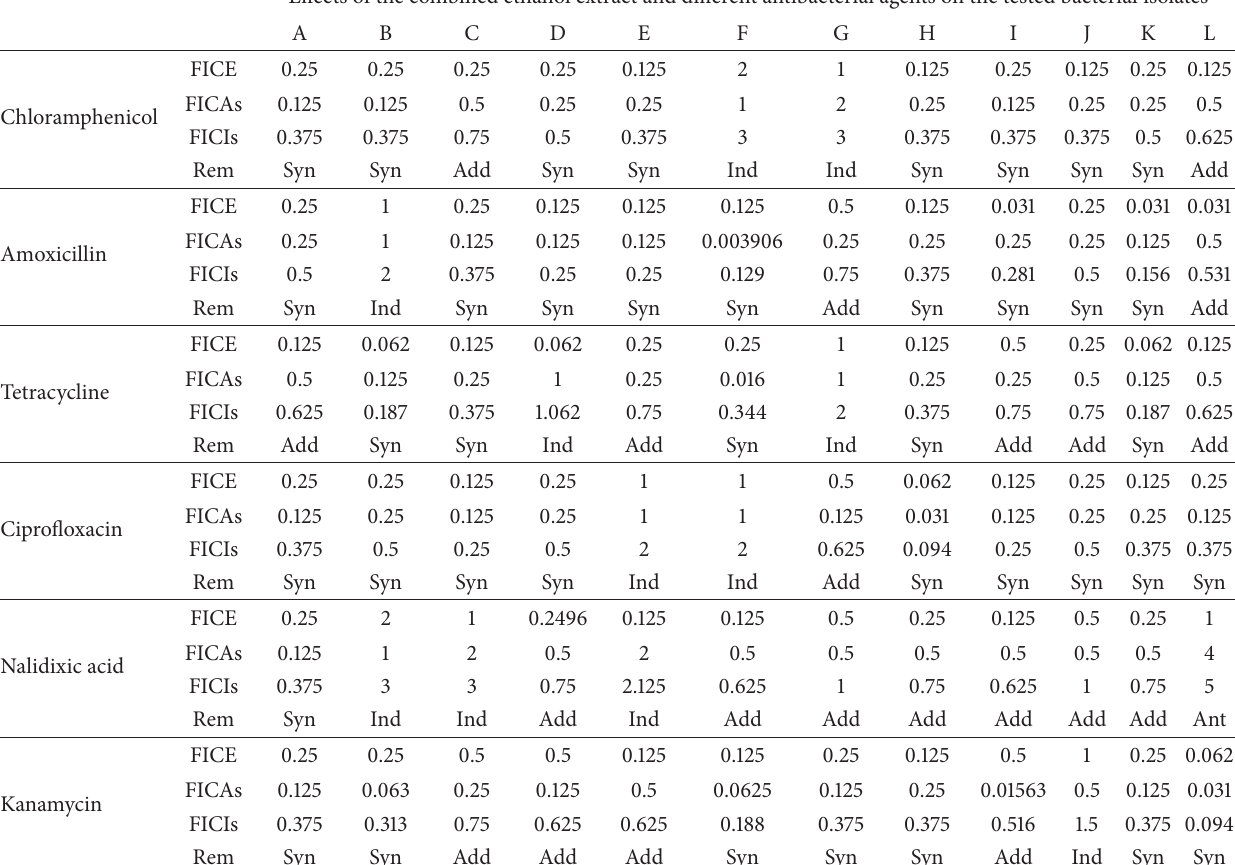
Table 3: Effects of combining ethanol extract of Ziziphus mucronata subsp. mucronata with antimicrobial agents against selected bacterial